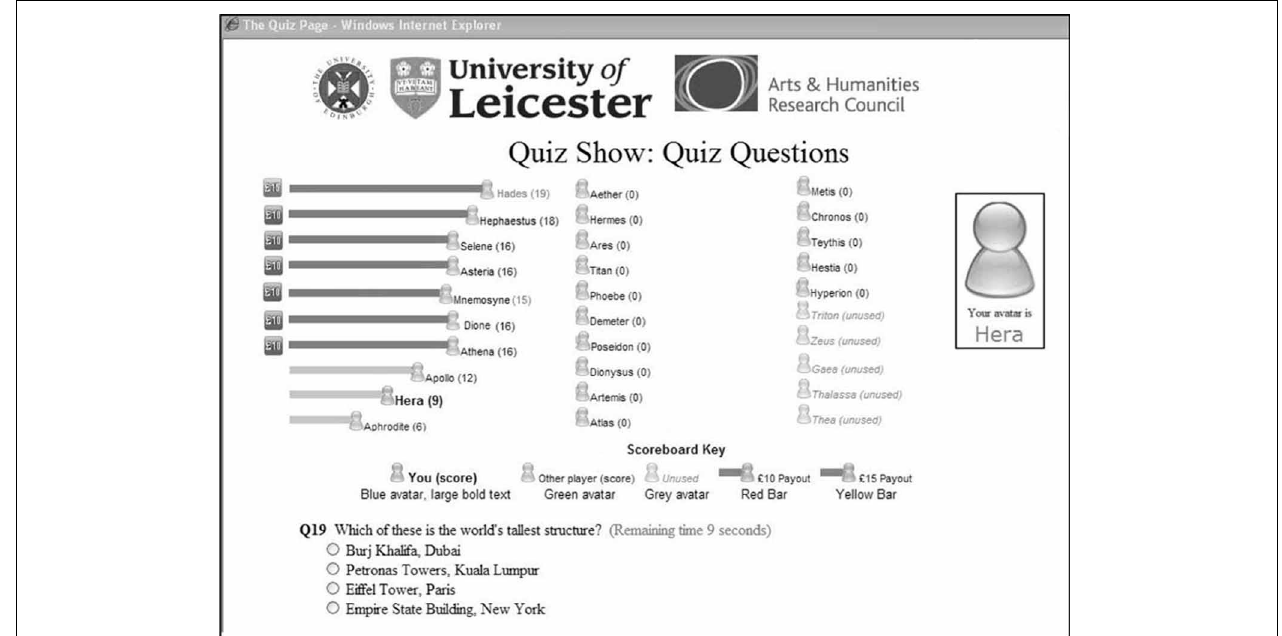
FIGURE 3 | Example of a subject’s monitor displaying the questions and the progress of the quiz show subjects.